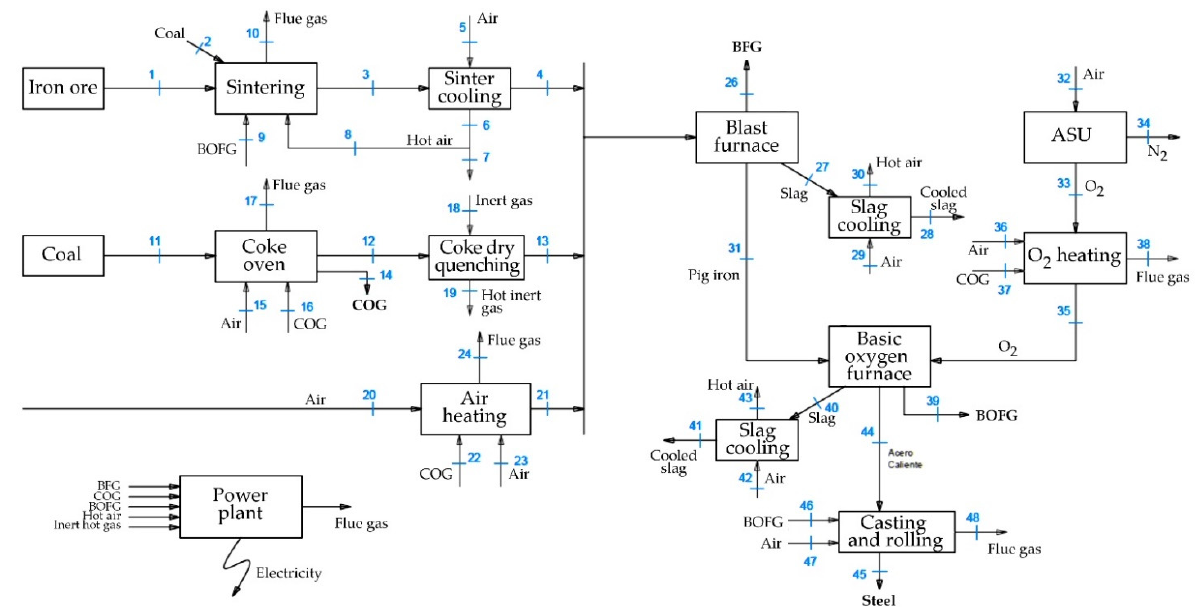
Figure 2. Block diagram of the reference ironmaking plant (Case 0).